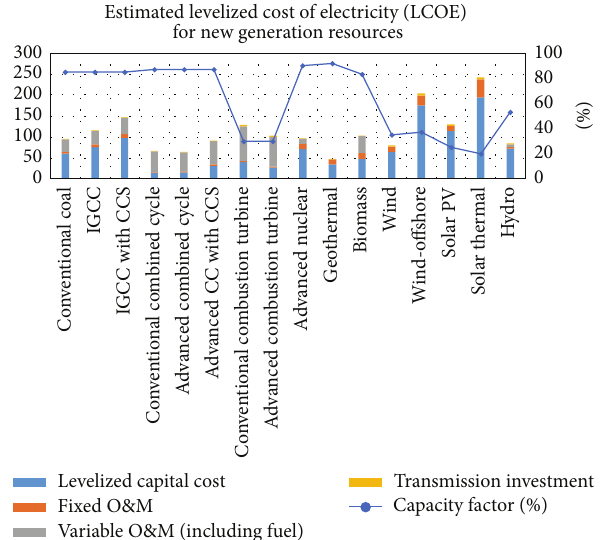
Figure 1: Estimated levelized cost of new generation resources (2019). Source: the Energy Information Administration Annual Energy Outlook,